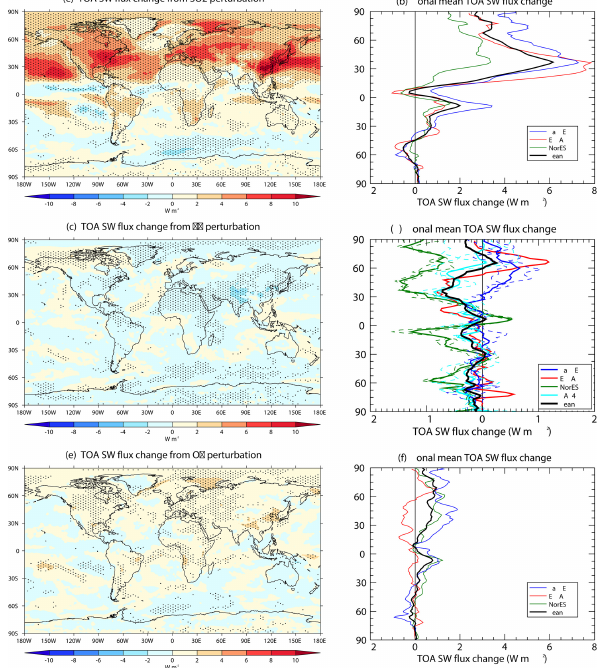
Figure 7. Annual average change in precipitation for (a, b) SO 2 , (c, d) BC and (e, f) OC perturbations. Left column: multi-model mean maps. Right column: zonal mean. In (a, c, e) , stippling shows points where the response is significant at the 95%